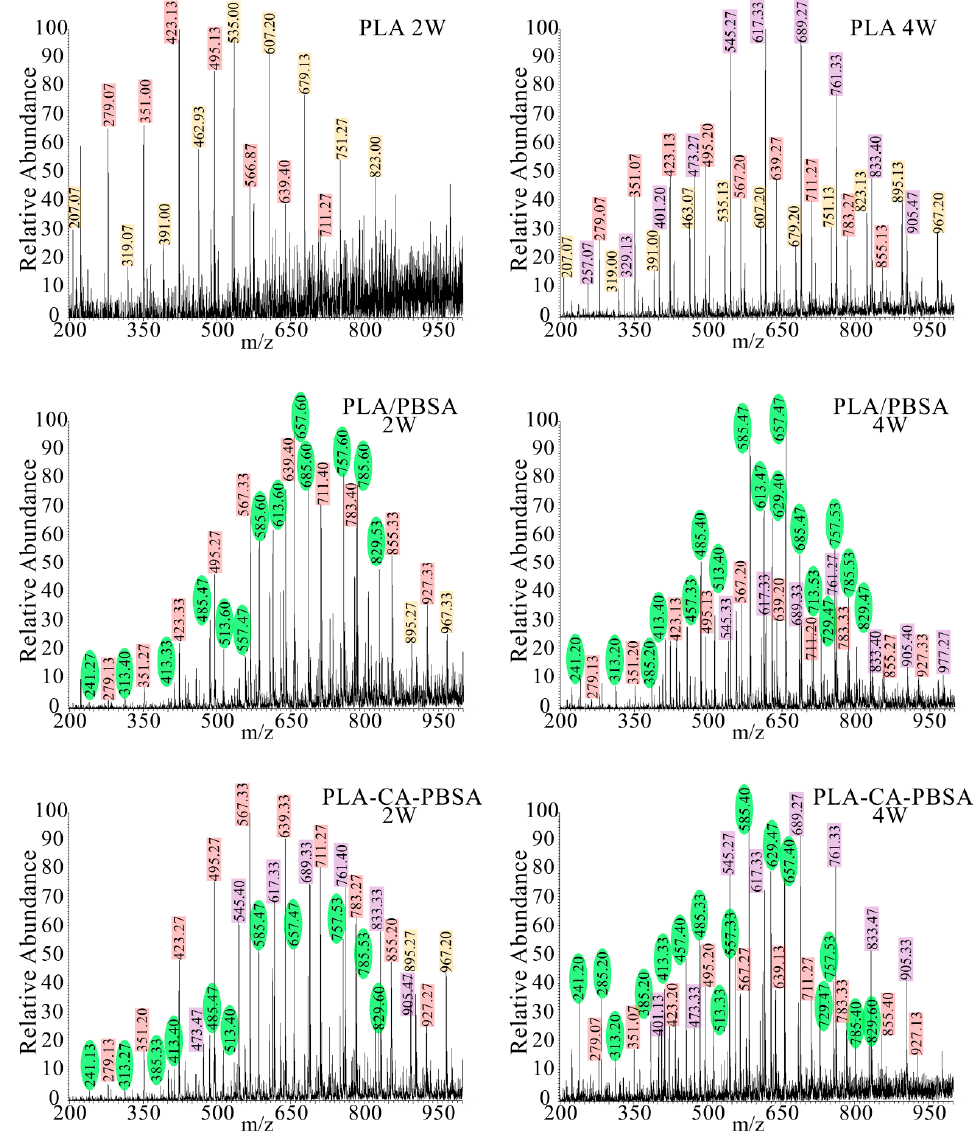
Figure 8. ESI-MS mass spectra after 2 and 4 weeks of hydrolysis at 60 °C (o-LA, yellow, pink and purple rectangle; PBSA, green oval).